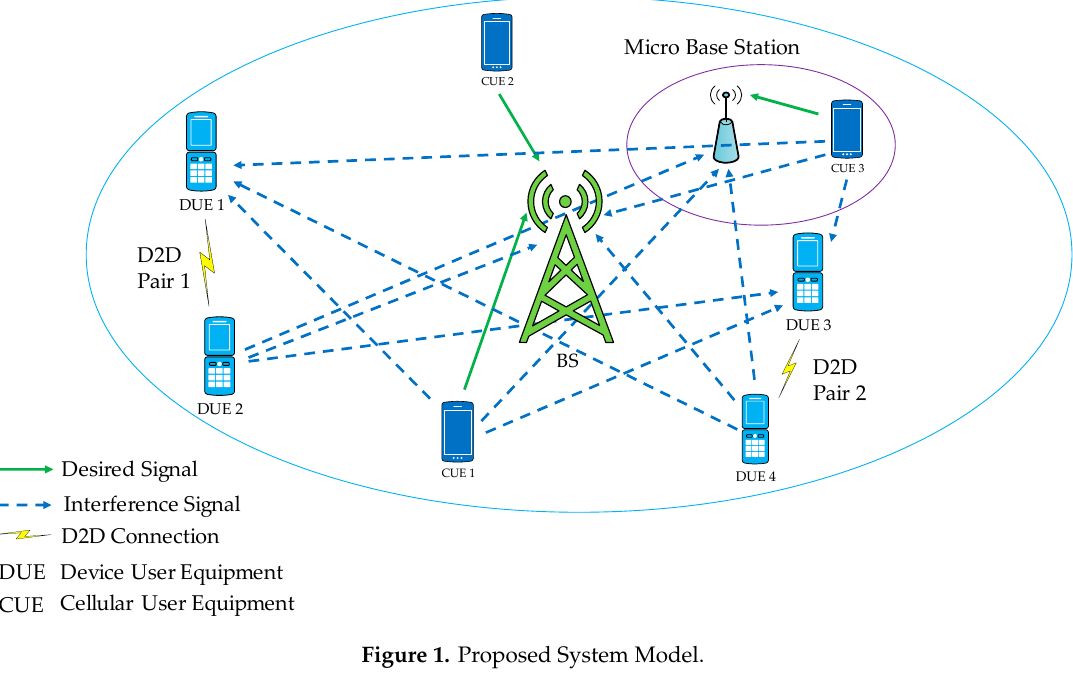
Figure 1. Proposed System Model.